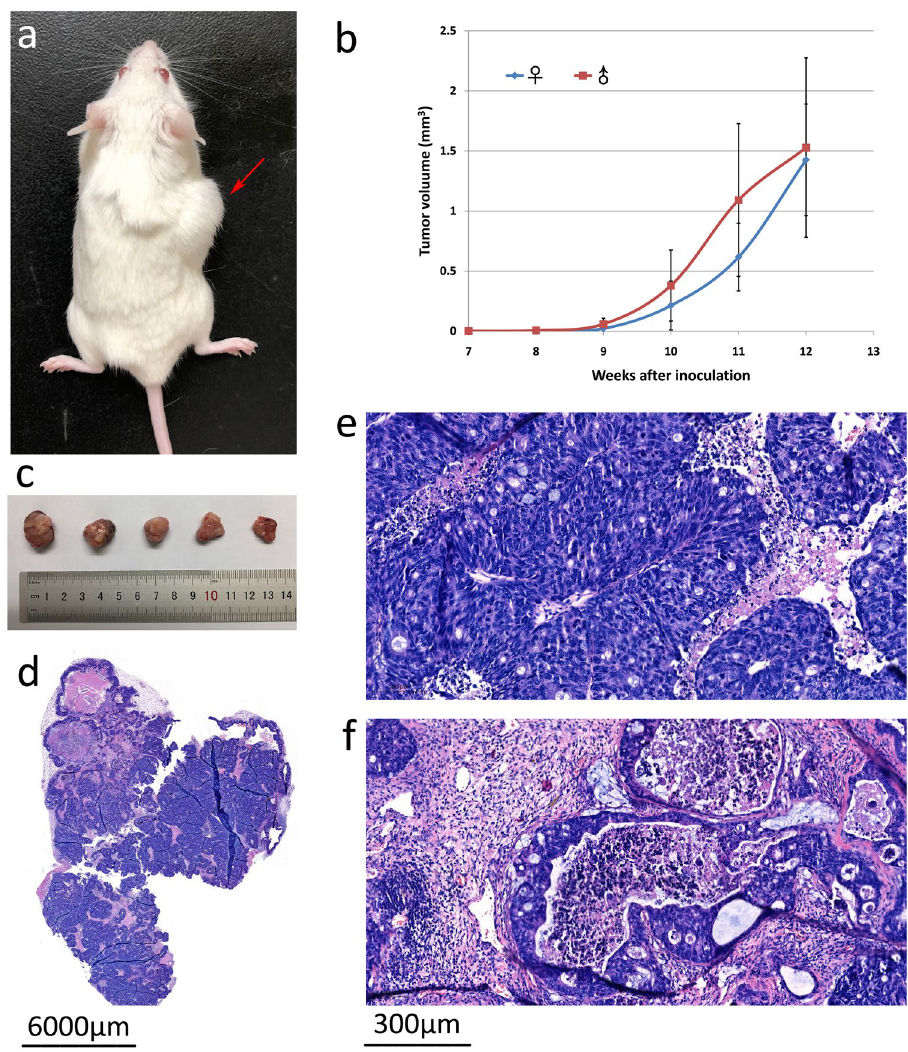
Figure 3. In vivo size assessment and histological analysis of the xenograft tumors in SCID mice. ( a ) Subcutaneous tumor mass (arrow indicated) in SCID mice which inoculated with 6 × 10 6 PUMC-CRC1 cells at 3 months post-injection. ( b ) Growth curve of the xenograft tumors in female and male SCID mice (n = 5, age 5–6 weeks), which started to increase in size at around 9 weeks after inoculation. ( c ) Xenografts derived from PUMC-CRC1 cells. ( d–f ) H&E staining of the paraffin-embedded tissue section confirmed that the xenograft tumor was moderately to poorly differentiated colorectal adenocarcinoma: ( d ) whole slide image of the xenograft tumor under low magnification; ( e ) irregular glandular cavity formation and cribriform structure; ( f ) cribriform structure and “dirty necrosis” within the glandular